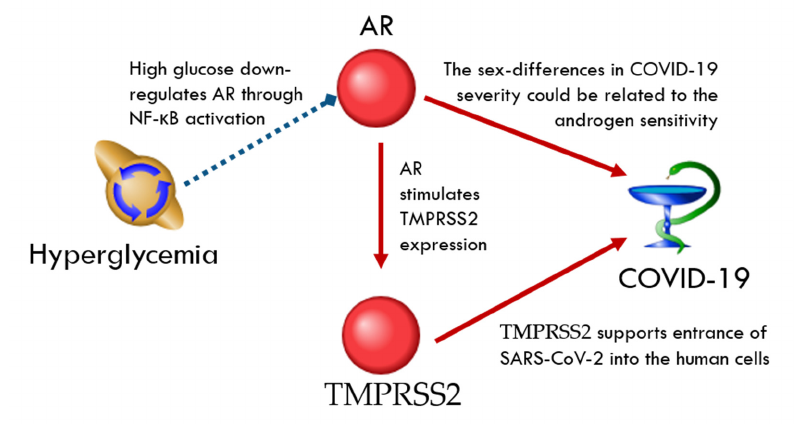
Figure 6. The regulation loop in the TMPRSS2-related network involves AR. The red arrows corre- spond to the up-regulation and the blue arrow corresponds to the down-regulation.